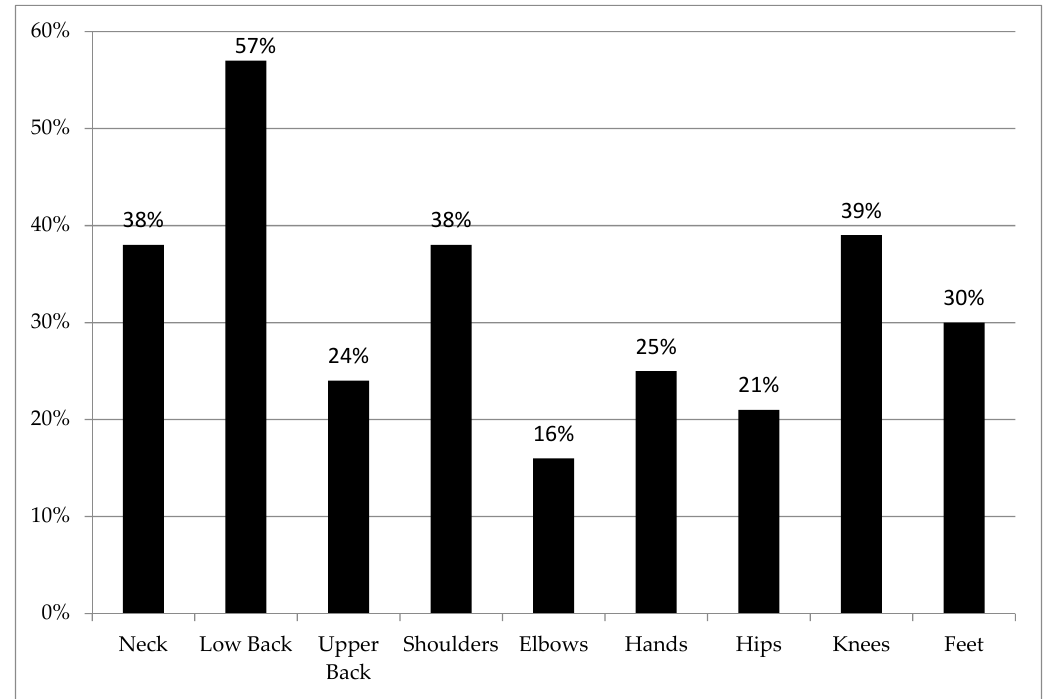
Figure 1. Percentage of stone, sand and gravel mining (SSGM) employees who experienced musculoskeletal symptoms (MSS) over the past 12 months on different body parts .